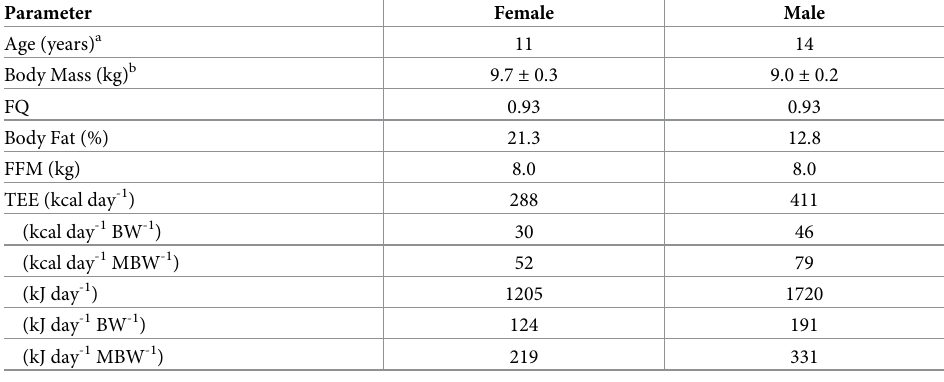
Table 1. Total energy expenditure (TEE) of zoo-housed Matschie’s tree kangaroos ( Dendrolagus matschiei ). Parameter